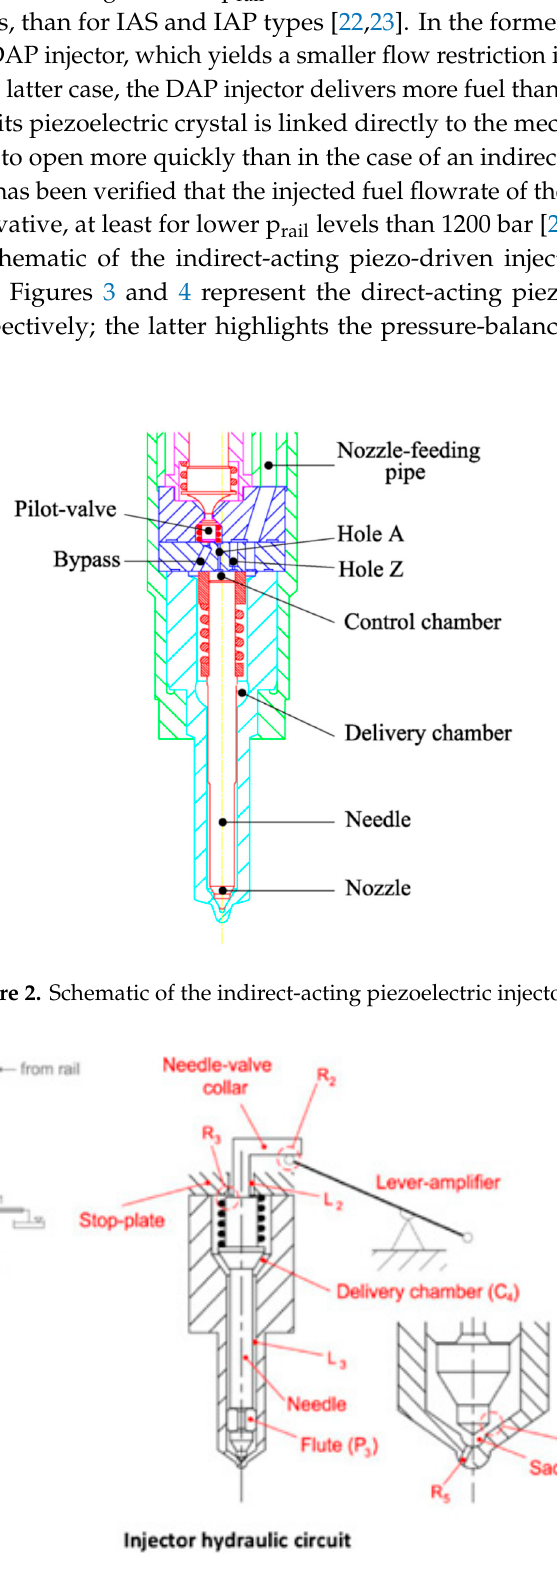
Figure 3. Schematic of the direct-acting piezoelectric injector.